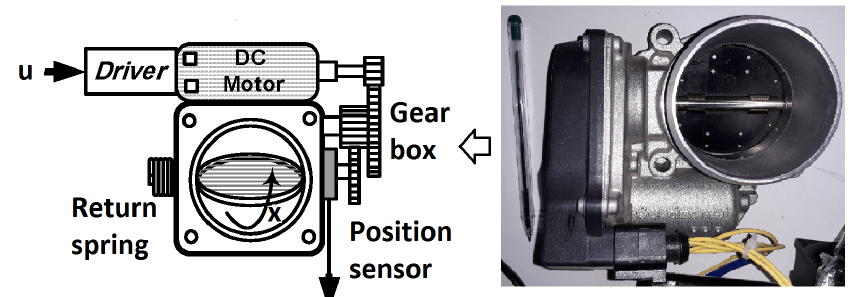
Figure 1. A general schematic representation of a throttle device. The shown throttle body is manufactured by Continental Siemens VDO, Model A2C59511705, P.N. 06F133062J and employed by many vehicles [6]. In addition, x = x ( t ) and u = u ( t ) are the throttle plate angular position and the control input,